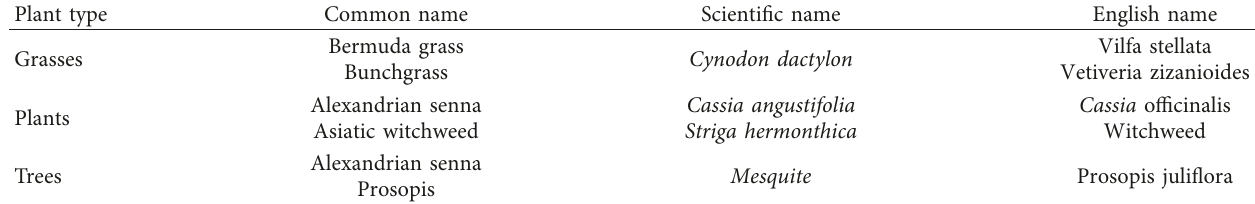
Figure 11: Different types of native vegetation in the area of Al Hosh highway. (a) Cassia angustifolia ; (b) Cynodon dactylon ; (c) Striga hermonthica ; (d) Vetiver . Table 9: Suitable plant selection according to native plant around Al Hosh highway.